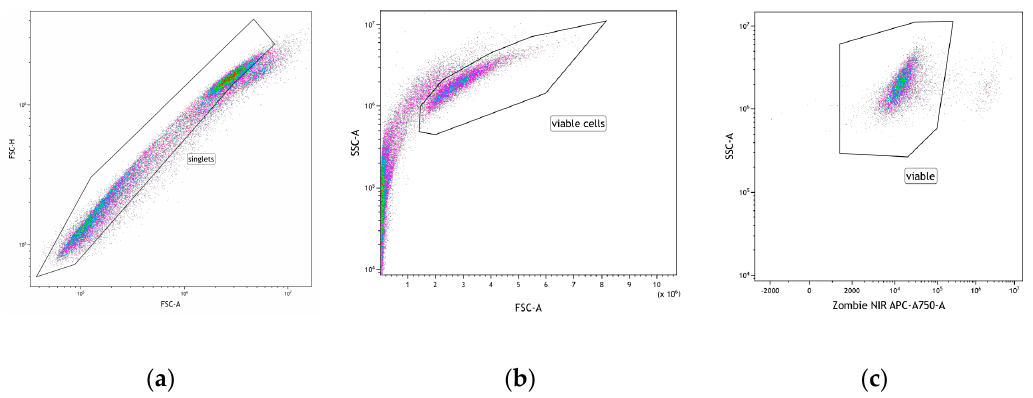
Figure A1. Viable cell gating strategy ( a–c ) for consecutive analysis of immune checkpoint molecules on the cell surface of tumor cells.